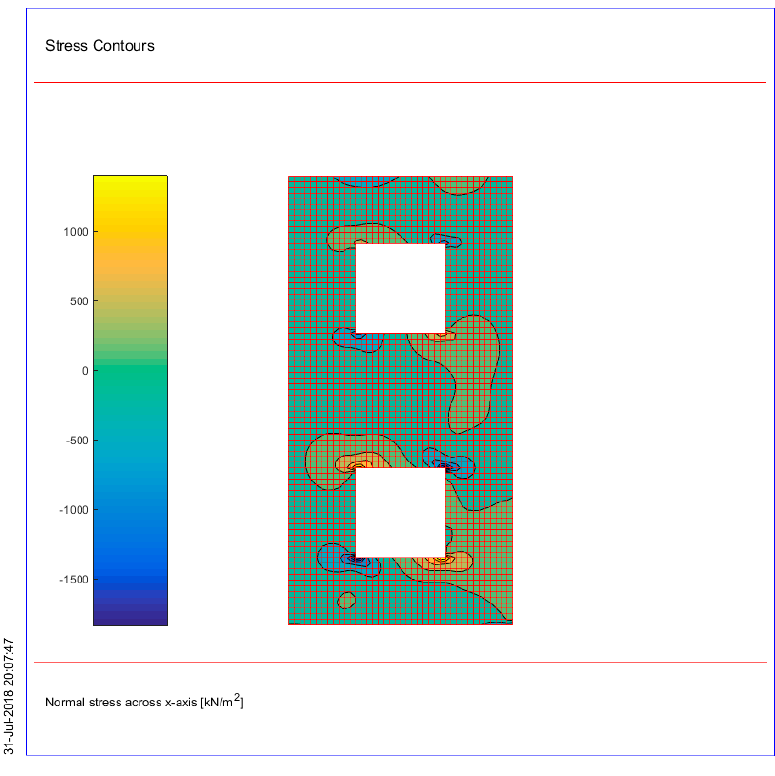
Figure 18. Stress contours of normal stress across x-axis (PGA = 0.40 g).